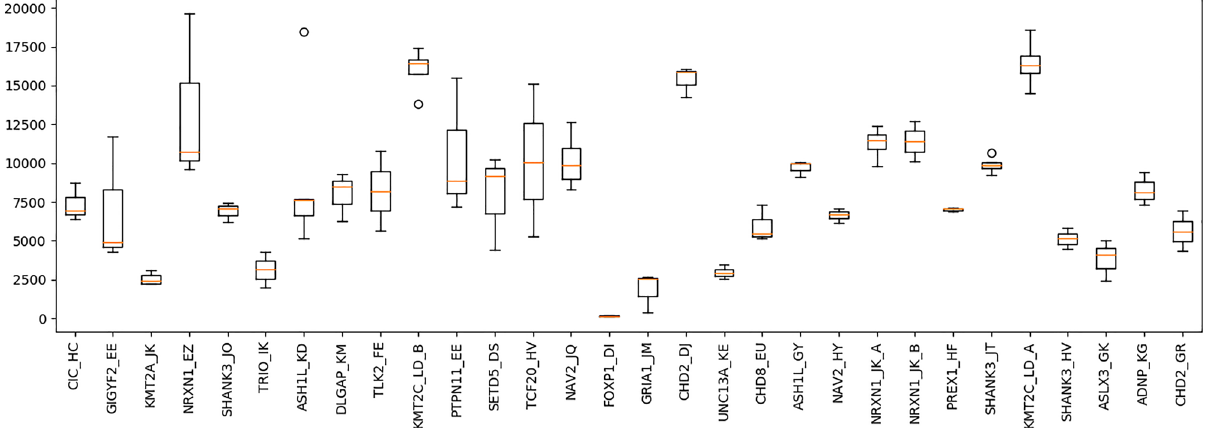
Figure 2. Depth of coverage of target regions. The name of each target region represents the gene name and the assigned pedigree ID. The average depth of sequence coverage varied significantly for different PCR amplicons, between 19,626.4 and 127.53 fold. The depth of coverage for PCR amplicons was significantly more uniform within target regions than between, with the average depth per target region varying significantly between 158× and 16418× [ANOVA: F(29, 70) = 10.05; P = 2.446 × 10 −15 ]. Statistical outliers indicated by circles.